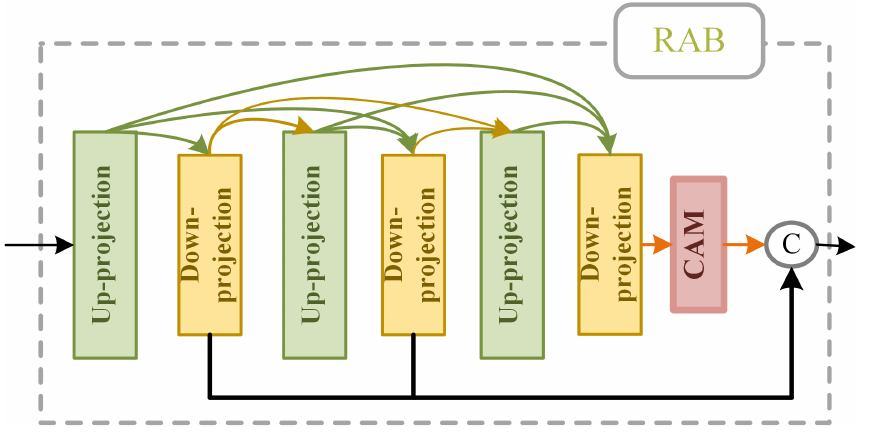
Figure 4. Residual attention